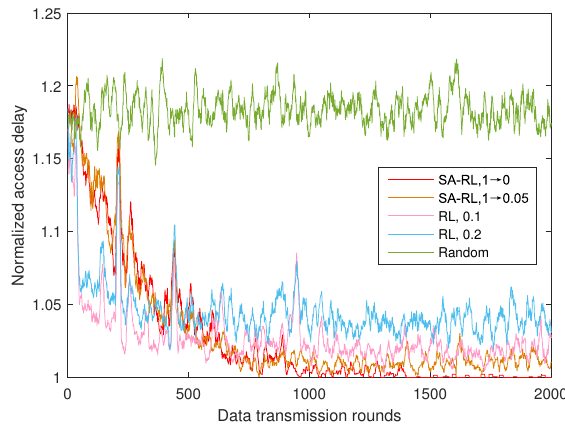
Figure 8. Comparison of access delay of RL with/without SA